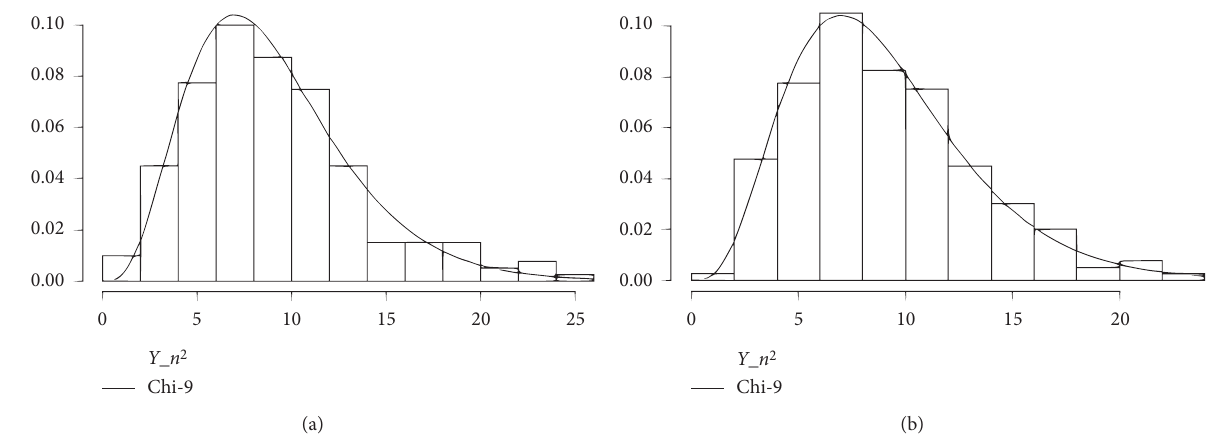
Figure 12: 􏽢 α � 0 . 5, 􏽢 c � 1 . 5, and 􏽢 a � 0 . 5 (a) and 􏽢 α � 2 . 5, 􏽢 c � 0 . 9, and 􏽢 a � 2